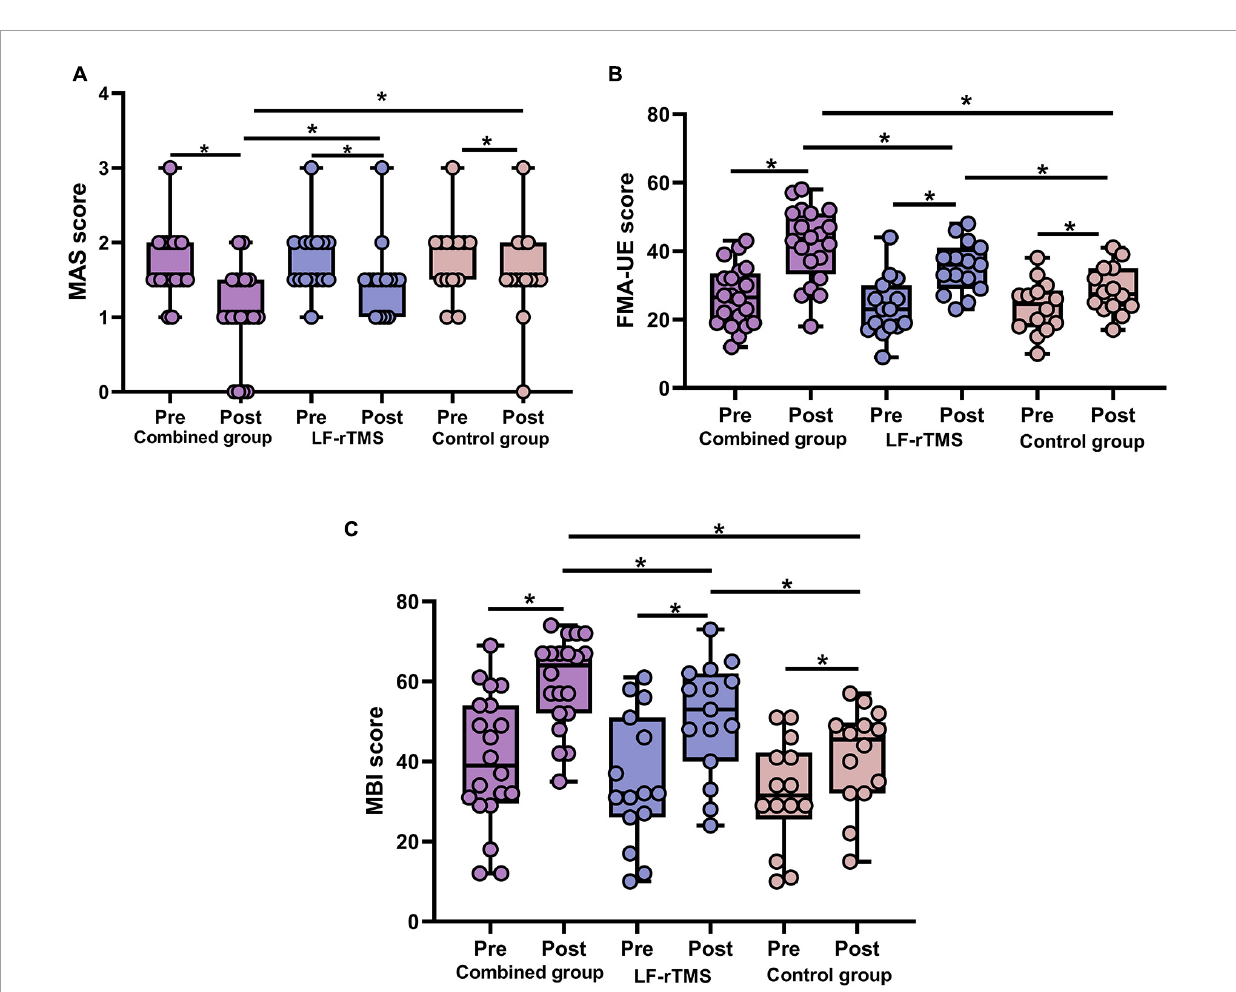
FIGURE2 Behavioral changes in the combined group, LF-rTMS group and control group. (A) The MAS score was decreased post-treatment compared with pre-treatment in the three groups. After treatment, the combined group had a lower MAS score than the other two groups. (B) The FMA-UE score was higher post-treatment than pre-treatment in the three groups. The combined group had a higher FMA-UE score than the other two groups after treatment. (C) After treatment, the three groups showed improvements in the MBI. The MBI score was higher in the combined group compared with the control group and LF-rTMS after treatment. * P < 0.05. MAS, Modified Ashworth Scale; FMA-UE, upper extremity Fugl-Meyer Assessment; MBI, modified Barthel index; Pre, pretreatment; Post,